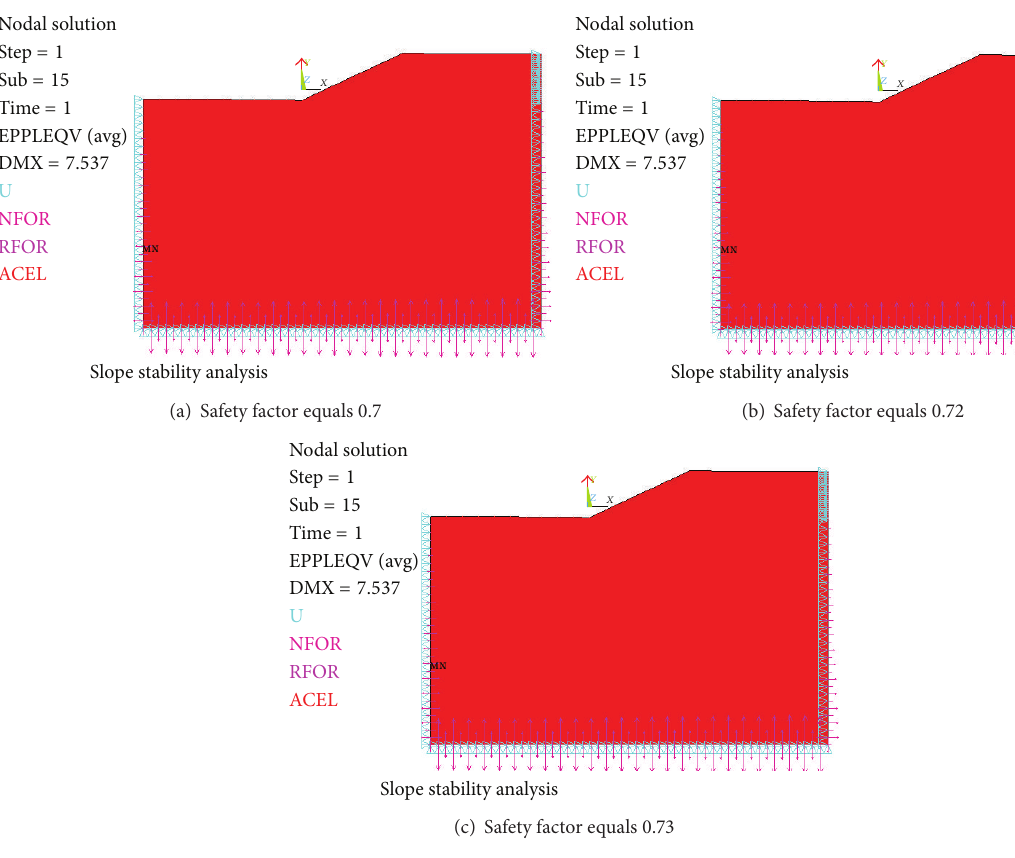
Figure 15: No von Mises plastic